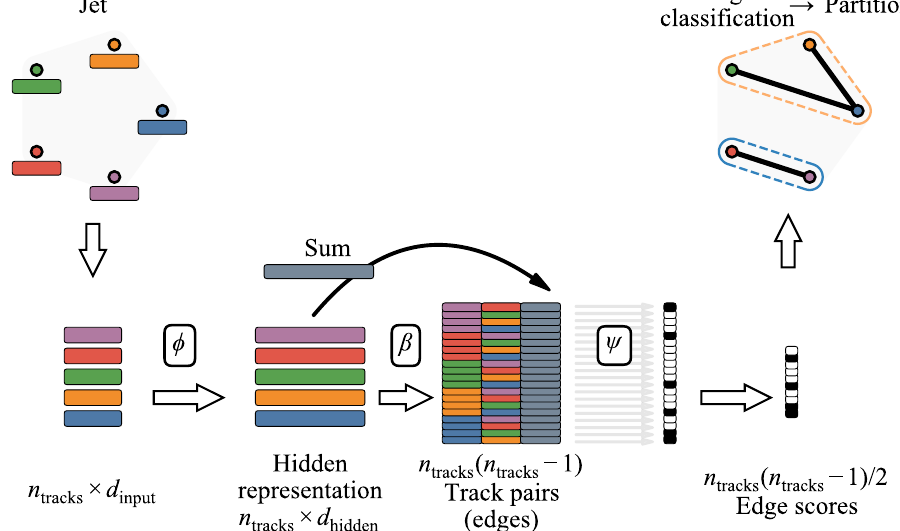
Fig. 4 Partitioning a set of jet tracks using a neural network. A set-to- set component, φ , creates a hidden representation of each track, with size d hidden . A broadcasting layer β , then creates a representation for each directed edge (ordered pair of tracks in the jet) by combining the representation of the two tracks and the sum of all representations. An